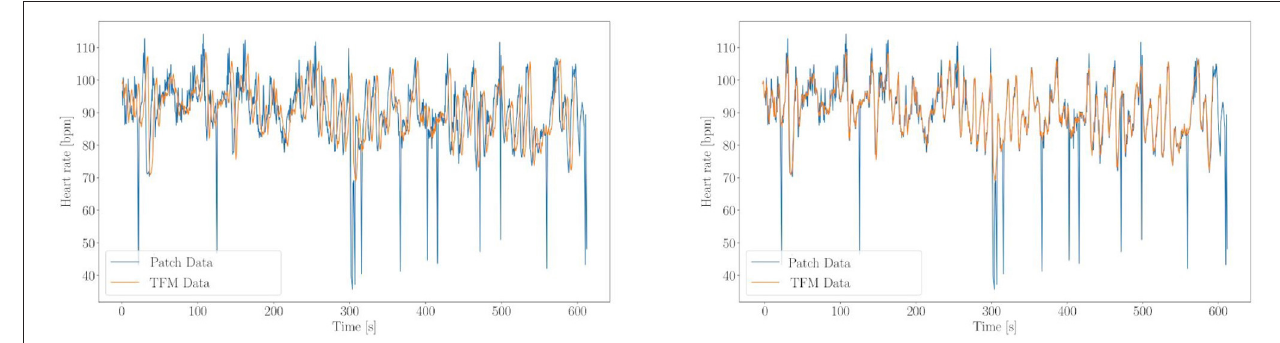
FIGURE 4 | Example of timestamp matching (subject 1 position 2). On the left side HR over time is shown of SP (blue) and TFM (orange) before matching up the timestamp, on the right after. The sudden drops in the HR of the SP can be explained with missed beats (this will half the HR of the next beat since the interbeat interval is now twice as long).